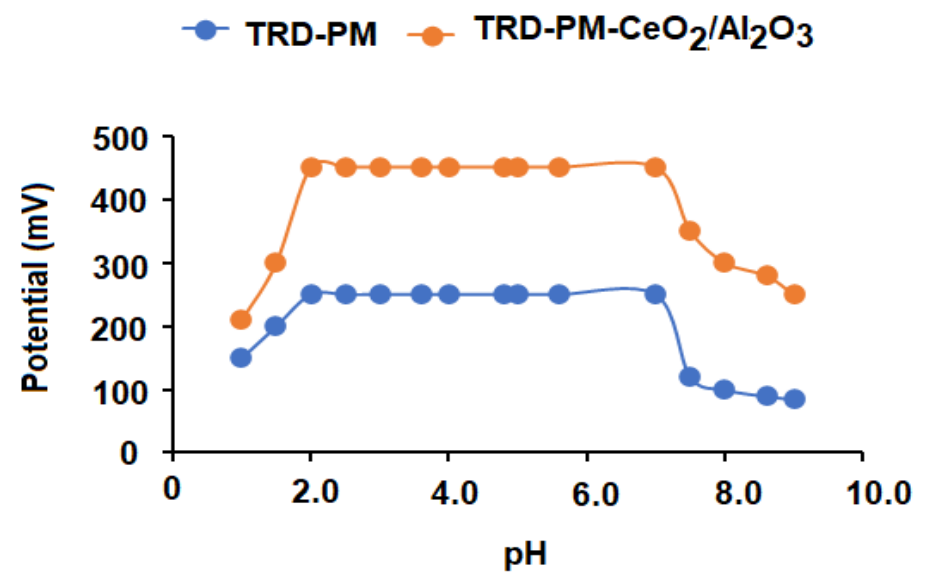
Figure 11. Effect of hydrogen ion concentration (pH) on the potential readings of the conventional and functionalized metal oxide nanocomposite sensors using 1.0 × 10 − 4 mol L − 1 TRD solution. A separate solution approach [67] was employed to assess the effect of interference of several foreign constituents on the coefficient of selectivity of the developed TRD sen- sors. The functionalized TRD-PM-CeO 2 /Al 2 O 3 nanocomposite sensor exhibited high selec- tivity towards the detection of TRD. The extraordinary physicochemical properties of the produced CeO 2 /Al 2 O 3 NPs, as well as their large interfacial area, improve the conductivity of the modified sensor and therefore its selectivity for TRD ions. Furthermore, the free energy transfer of ions (TRD + ) created between the active sites in the membrane and the working solution is referred to by the TRD coated membrane selectivity. The evaluated cations, sugars, and amino acids caused no interference. As a result, using the modified TRD sensor for TRD determination provided high selectivity and tolerance (Table 2).